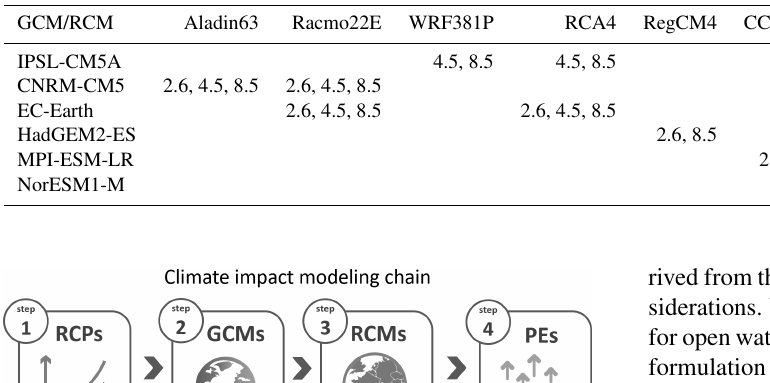
Table 1. The available climate projection data. The numbers (2.6, 4.5 and 8.5) refer to the RCPs used by the GCM–RCM pairs (GCMs shown in the rows, and RCMs shown in the columns). Empty boxes or missing RCPs show an absence of data.